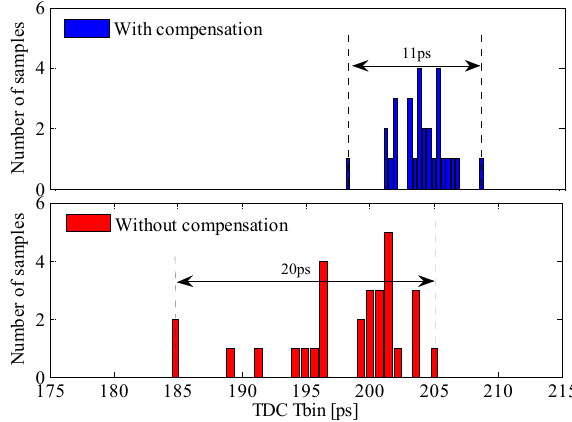
Figure 14. Measured process variation effect on the TDC T bin